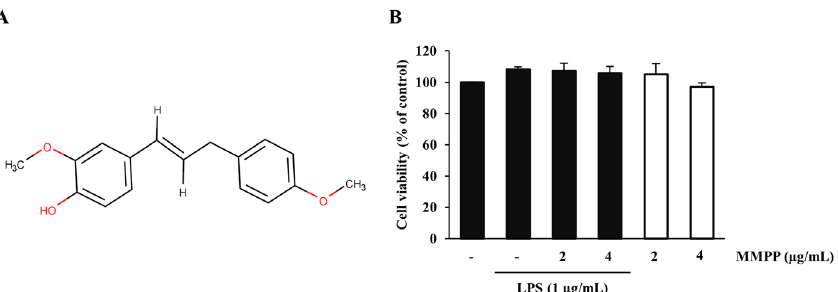
Figure 1. Chemical structure and cytotoxic effects of MMPP . ( A ) Chemical structure of MMPP. ( B ) The cytotoxic effects of MMPP and LPS on THP-1 cells were assessed by cell viability assay. THP-1 cells were co-treated with MMPP (2 and 4 µg/mL) and LPS (1 µg/mL) or MMPP alone for 24 h. Data are presented as the mean ± SD ( n = 3).